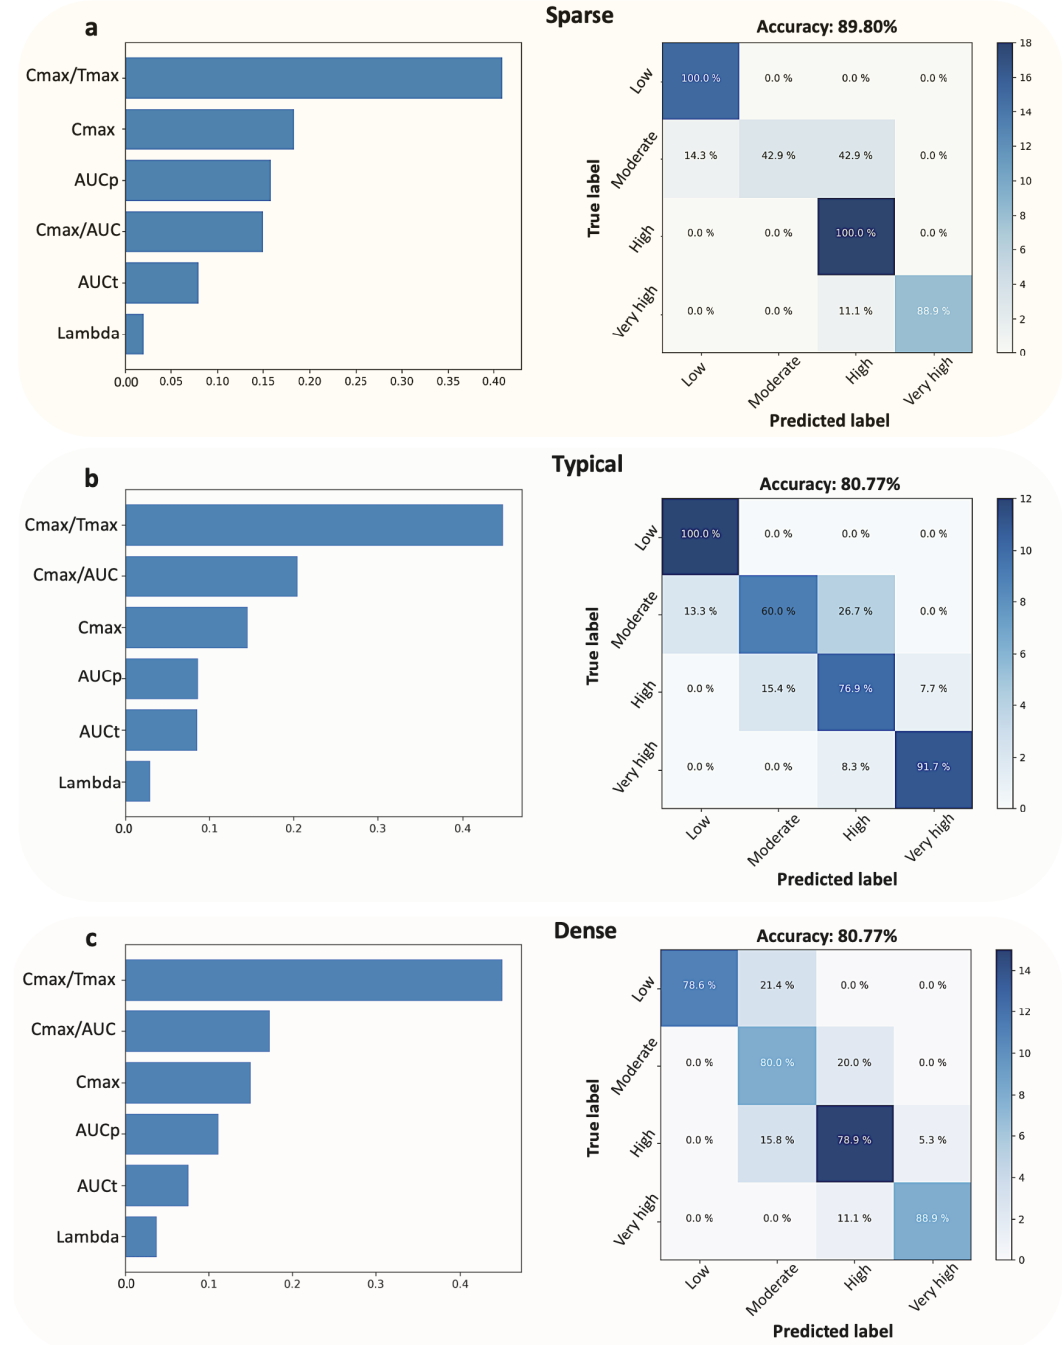
Figure 7. Variable importance scores and confusion matrices, in the case of simulated data, using Tmax as the response variable. The three separate random forest models developed correspond to sparse ( a ), typical ( b ), and dense ( c ) sampling schemes. The descriptors used for random forest models refer to the Cmax/Tmax ratio and other pharmacokinetic parameters listed in Table 1. The quartiles of the Tmax distribution were used to define its four categories.